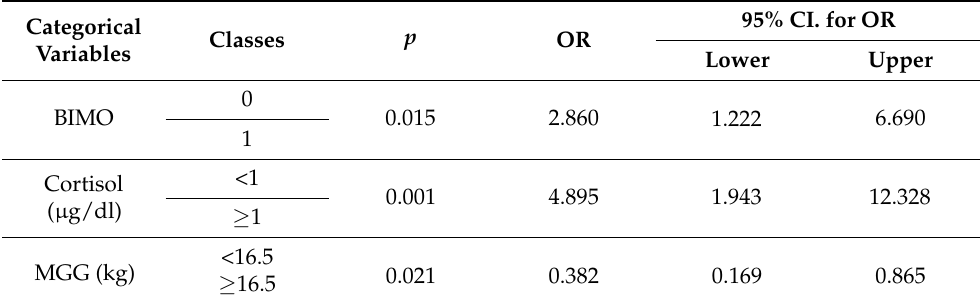
Table 6. Binary multivariable regressions factors indicating a statistically significant risk in predicting lameness of cows ( n =